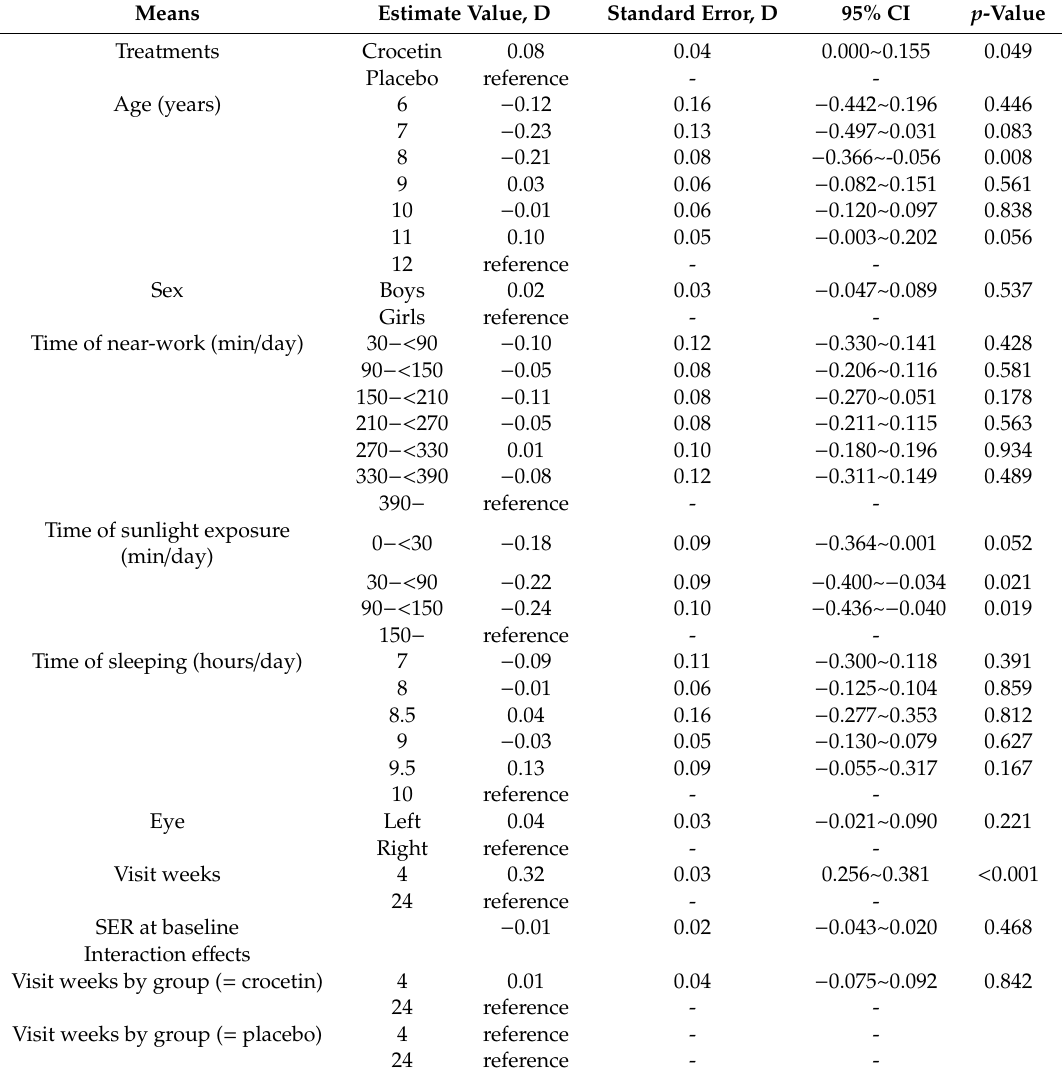
Table 2. Results of the mixed-e ff ects model fitted to 24-week SER change for both eyes ( n = 138). Means Estimate Value, D Standard Error, D 95% CI p -Value Treatments Crocetin Placebo reference